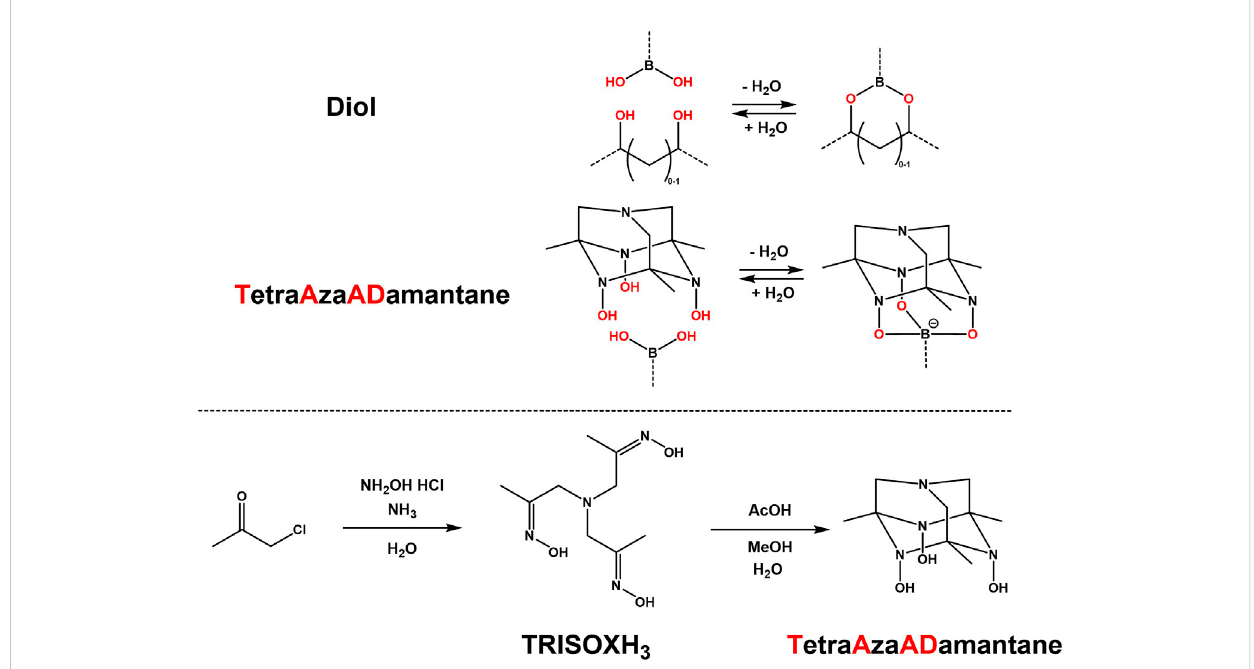
FIGURE 1 Comparison between (conventional) bidentate complexation of a boronic acid with a diol, and novel tridentate complexation by TetraAzaADamantane. Below, the synthesis pathway of tris-oxime TRISOXH 3 and subsequent conversion into TetraAzaADamantane as reported (Semakin et al.,